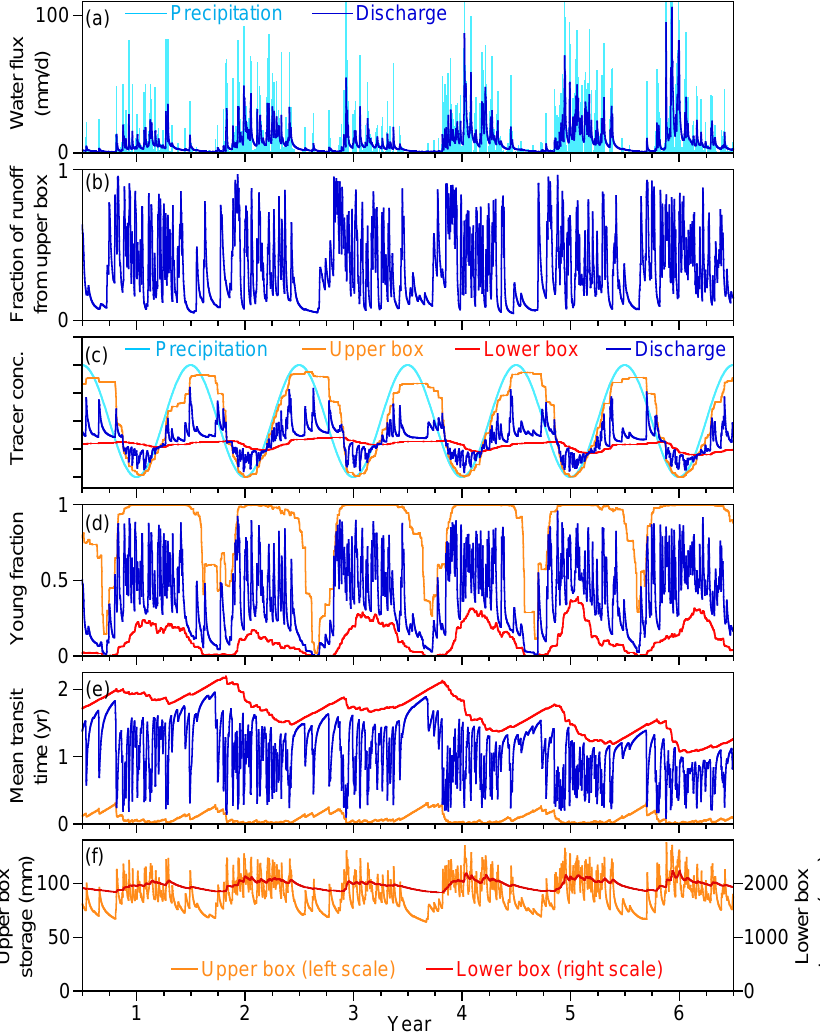
Figure 3. Illustrative time series from the two-box model, using the reference parameter set and the Smith River (Mediterranean climate) precipitation time series. Responses to precipitation events (a) entail rapid shifts in the proportions of discharge coming from the upper and lower boxes (b) . The smaller, upper box, shown in orange, has a larger young water fraction (d) and a younger mean age (e) than the larger, lower box, shown in red, and thus its tracer concentration (c) is less lagged and damped relative to the hypothetical precipitation concentration, shown by the cosine wave in (c) . Mean ages increase (e) and young water fractions decrease (d) , in both boxes, throughout the dry summer periods. The proportions of streamflow originating from the upper and lower boxes shift dramatically in response to transient precipitation inputs; thus, the tracer concentrations, young water fractions, and mean ages in discharge (dark blue, c – e ) vary widely between the time-varying end-members represented by the upper and lower boxes. Storage volumes fluctuate in a relatively narrow range (f) while discharge varies by orders of magnitude, because the drainage rates from both boxes are strongly nonlinear functions of storage. Thus, both boxes have sizeable residual storage, which is not drained even under extreme low-flow